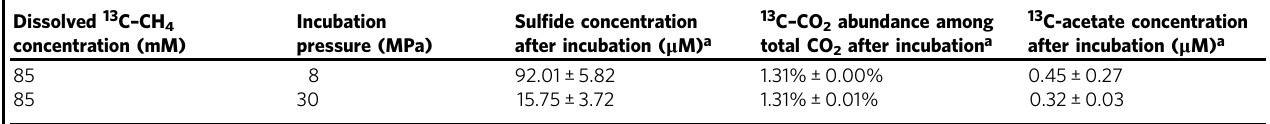
a Data are mean values with standard deviations from triplicate incubations.